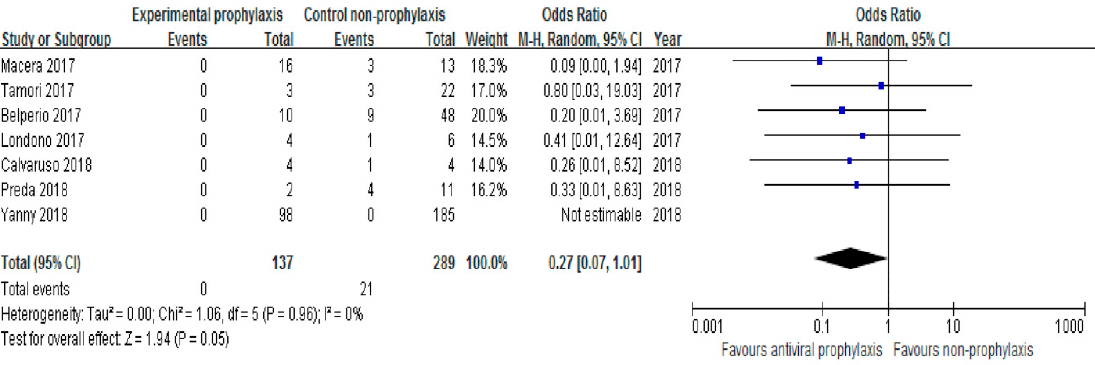
Figure 4. The risk of HBV reactivation according to prophylactic anti-HBV therapy.